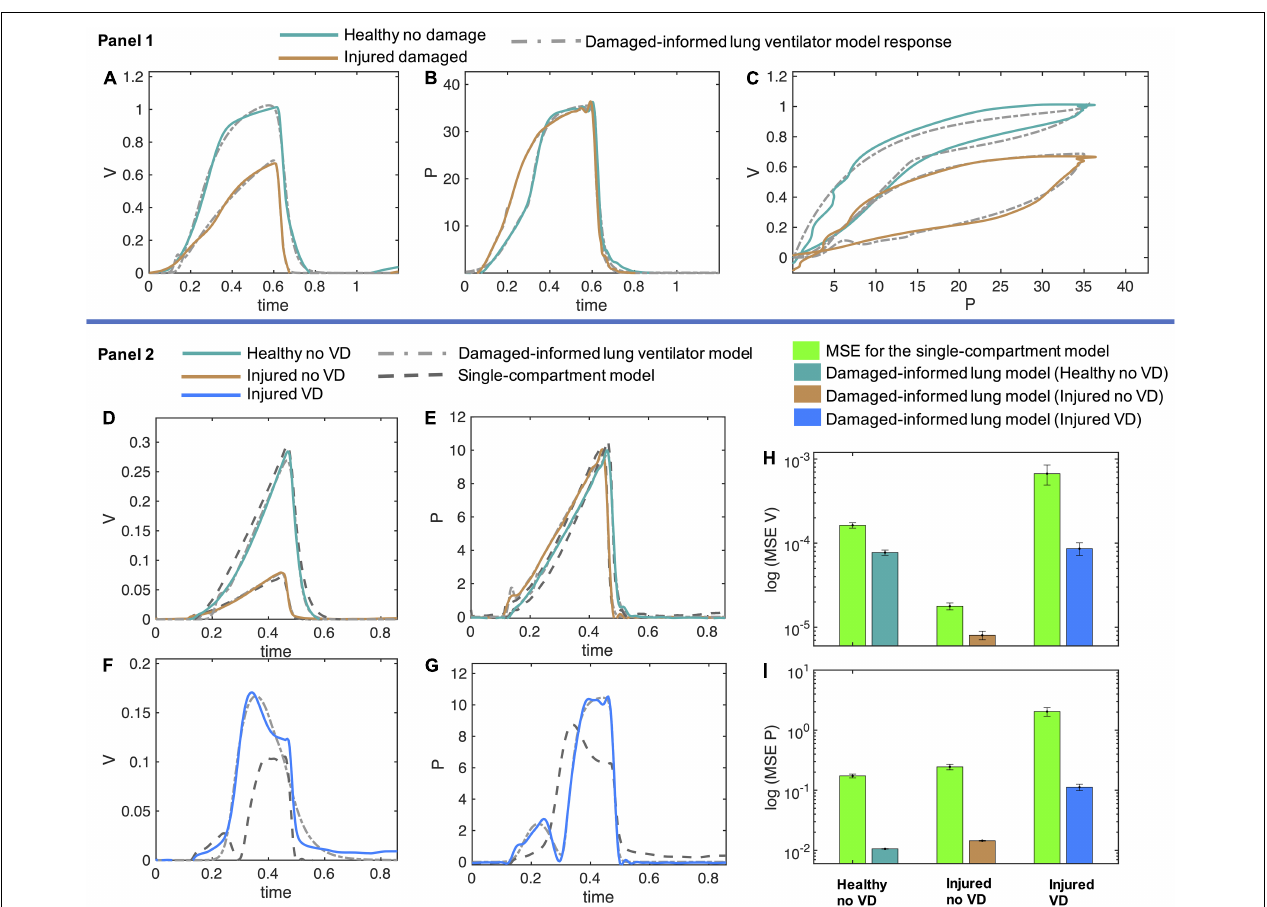
FIGURE 5 | Volume and pressure models’ responses closely agree with the experimental data from the representative mice in healthy and injured condition. (A–C) In Panel 1, the measured breaths of first mouse are shown in healthy and injured conditions (solid lines) while the damaged-informed lung ventilator (DILV) model response is shown in dashed lines. Equations 1–18 were used to generate the best-fit model response using estimated mean parameter values shown in Table 1 , respectively. (D–G) In Panel 2, three representative breaths of mouse two is shown here, which are corresponding to three different lung conditions (solid lines) while the damaged-informed lung ventilator model response is shown in the dashed-dot lines. For these breaths, histograms of the initial guesses and estimated parameters are shown in Supplementary Figure 6A . The response of the single-compartment model is shown in dashed-dashed lines. (F–I) The cumulative values of mean squares errors (MSE) of the two models are compared here. These values corresponded to sixty breaths for healthy no ventilator dyssynchrony (VD) and injured no VD cases while ten breaths for injured VD case. For each case and breath, the estimated parameter values and MSE are shown in the Supplementary Figures 6B–D . All the data shown here was collected in PCV (see “Materials and